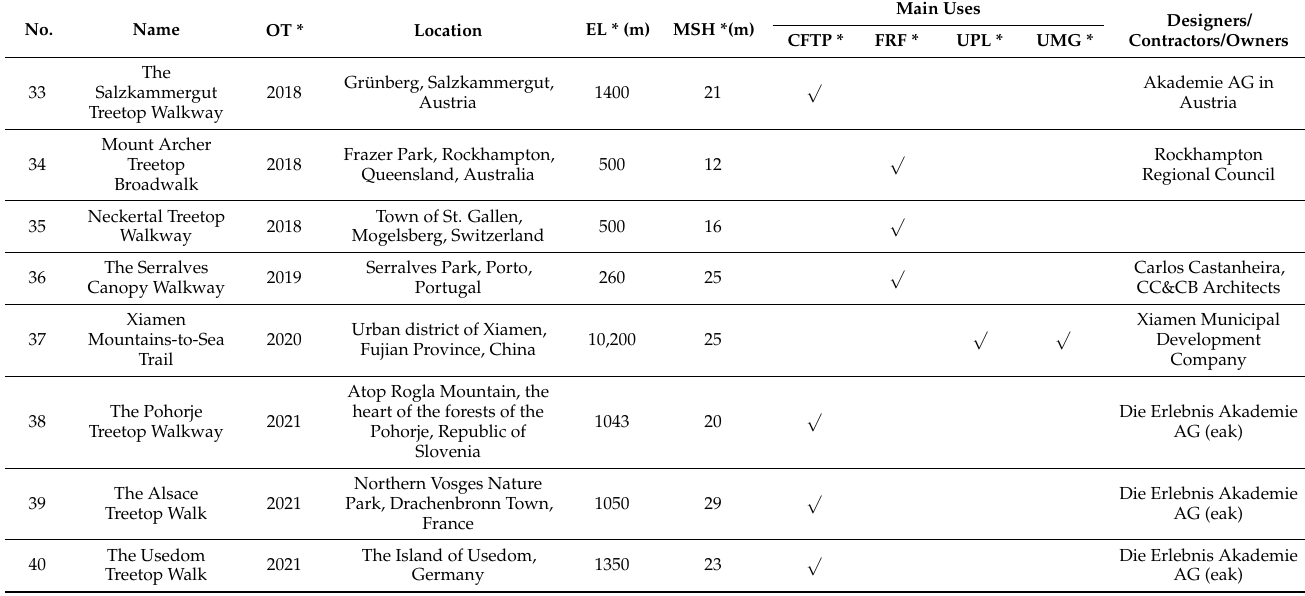
Figure A2. The treetop walkway of